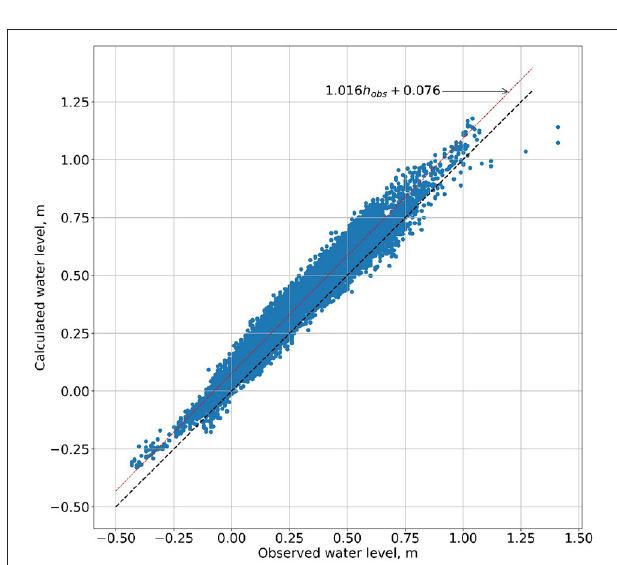
FIGURE 5 | Calculated vs. observed water level in the gauging station “Liepaja” located in the trade